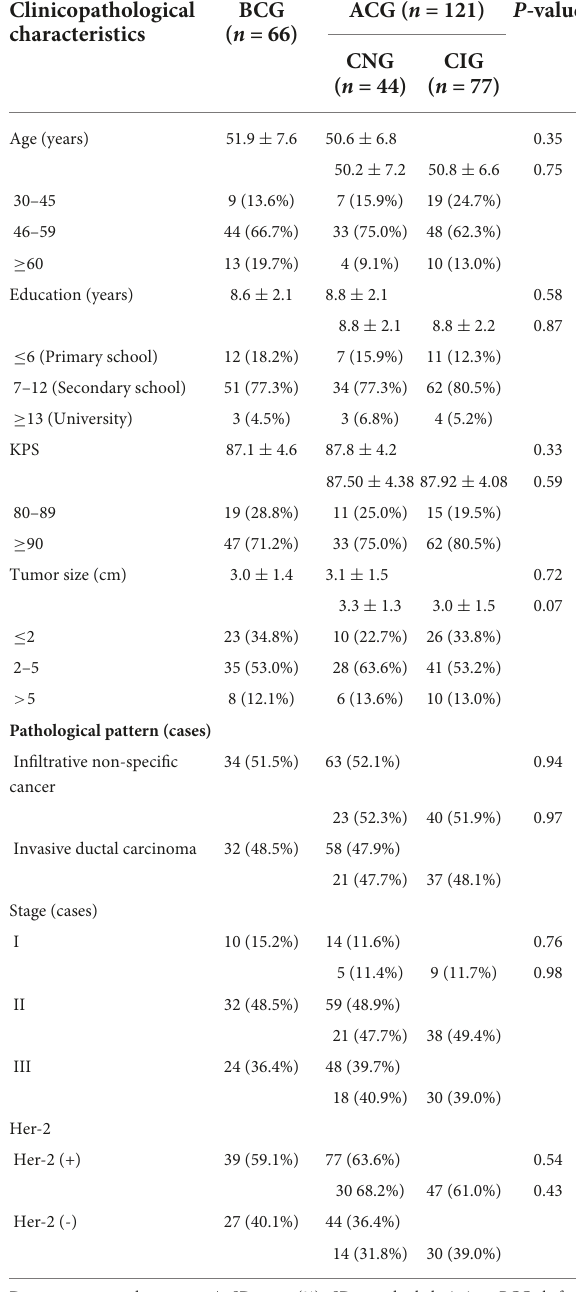
TABLE 1 The clinical characteristics of the patients ( N = 187).